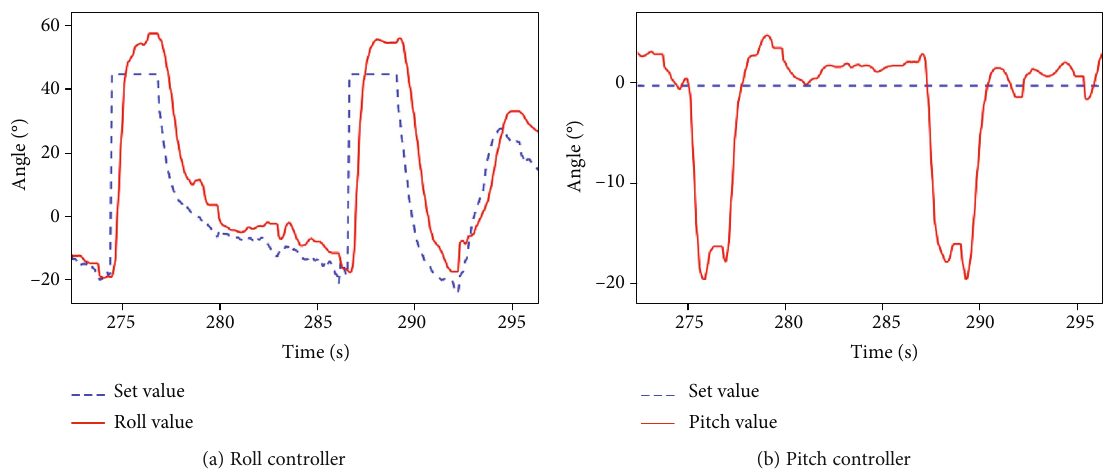
Figure 8: Behaviour of the roll and pitch controllers. In (a), the pilot changes the set value from -20 ° to +40 ° . The roll controller follows the command and tries to reach the desired position. Because of the coupling system, the pitch angle in (b) changes too and the airframe is dropping. The pitch controller and the decoupling controller are reacting to this and set the airframe in the right position.